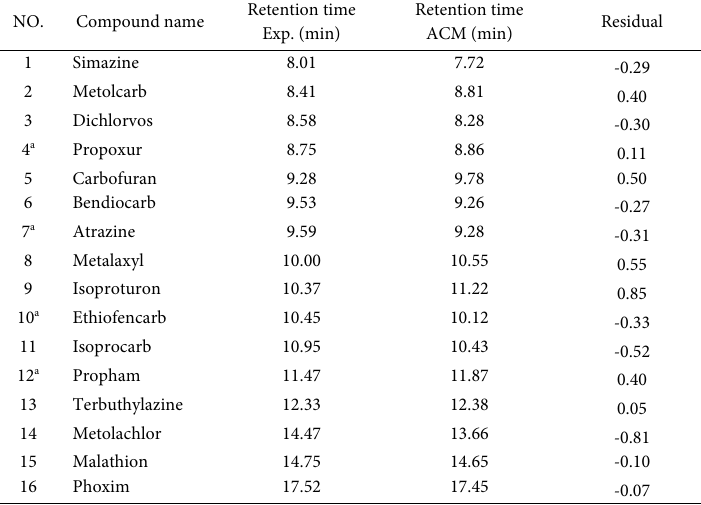
Table 1. Data set and experimental and predicted values of retention time by ACM.